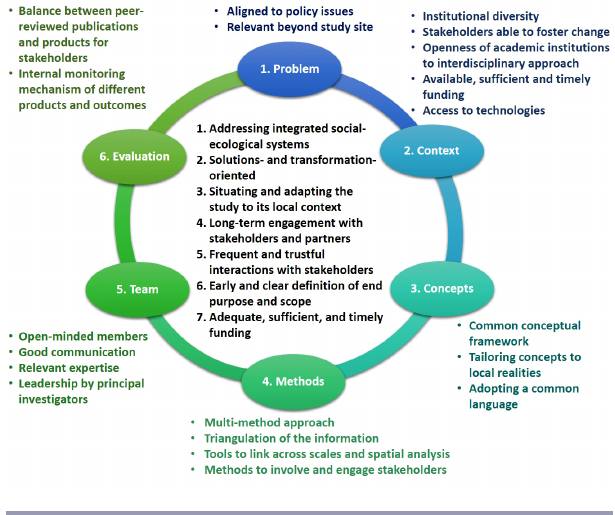
Fig. 4. Features, desirable aspects, and enabling factors that contribute to the success of place-based social-ecological research. Crosscutting features are in the center. Different types of features related to this type of research are outside the